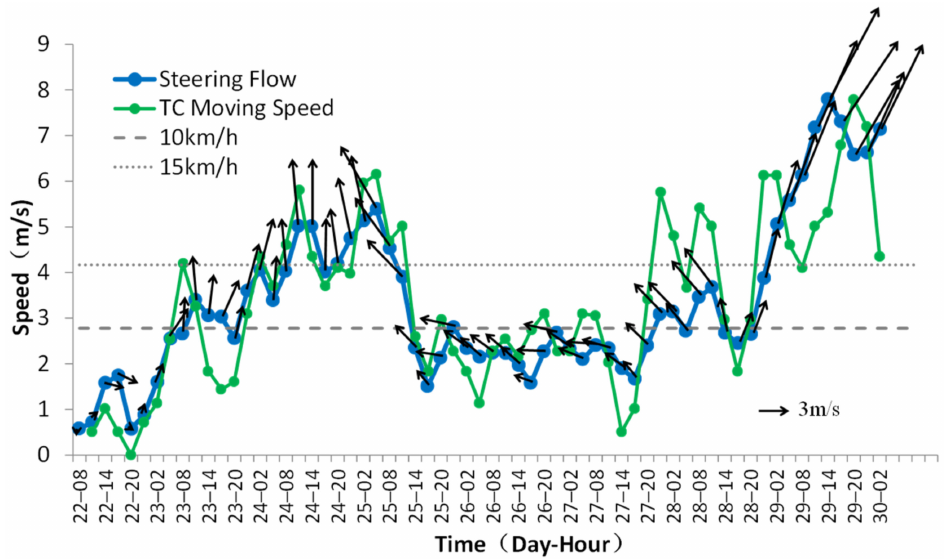
Figure 2. Time series of the magnitude (blue line) and direction (arrow) of steering flow, and the moving speed (green line) of In-Fa from 0800 BT on 22 July 2021, to 2000 BT on 29 July 2021.